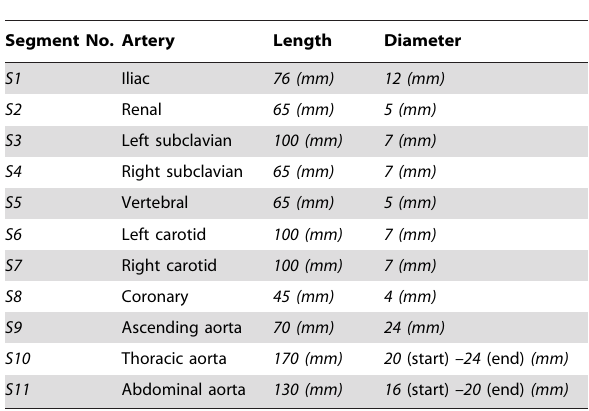
Segment No. Artery